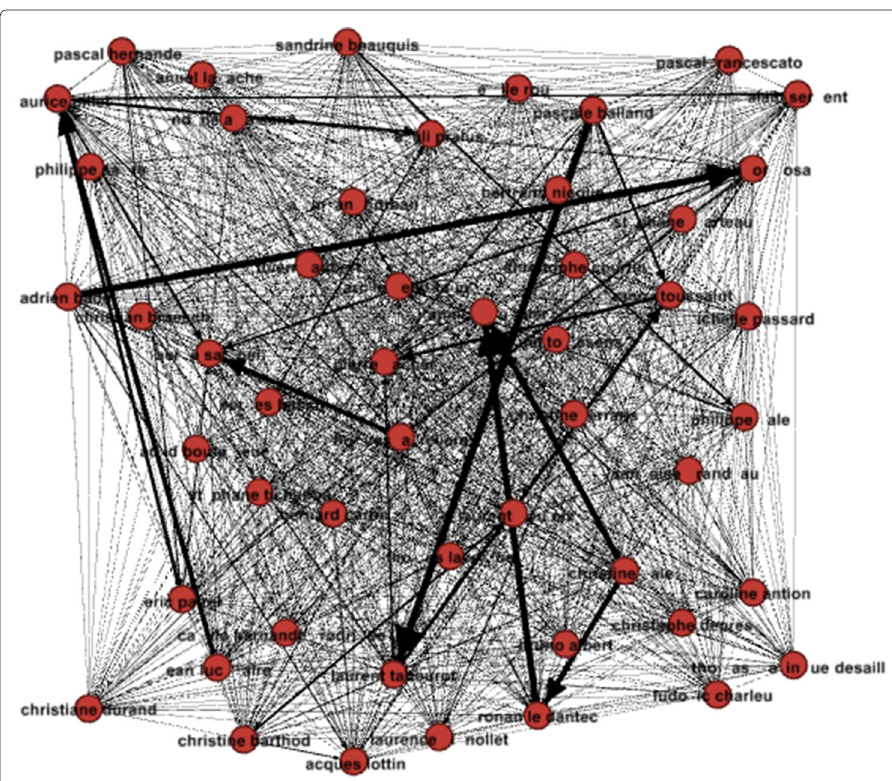
Fig. 6 Full Community Network generated with Gephi